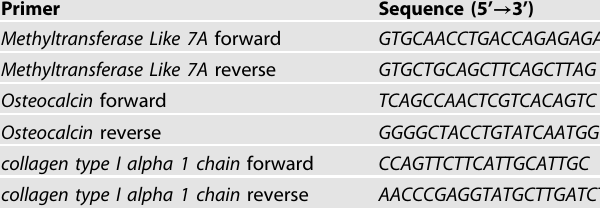
Table 1. The primers used in